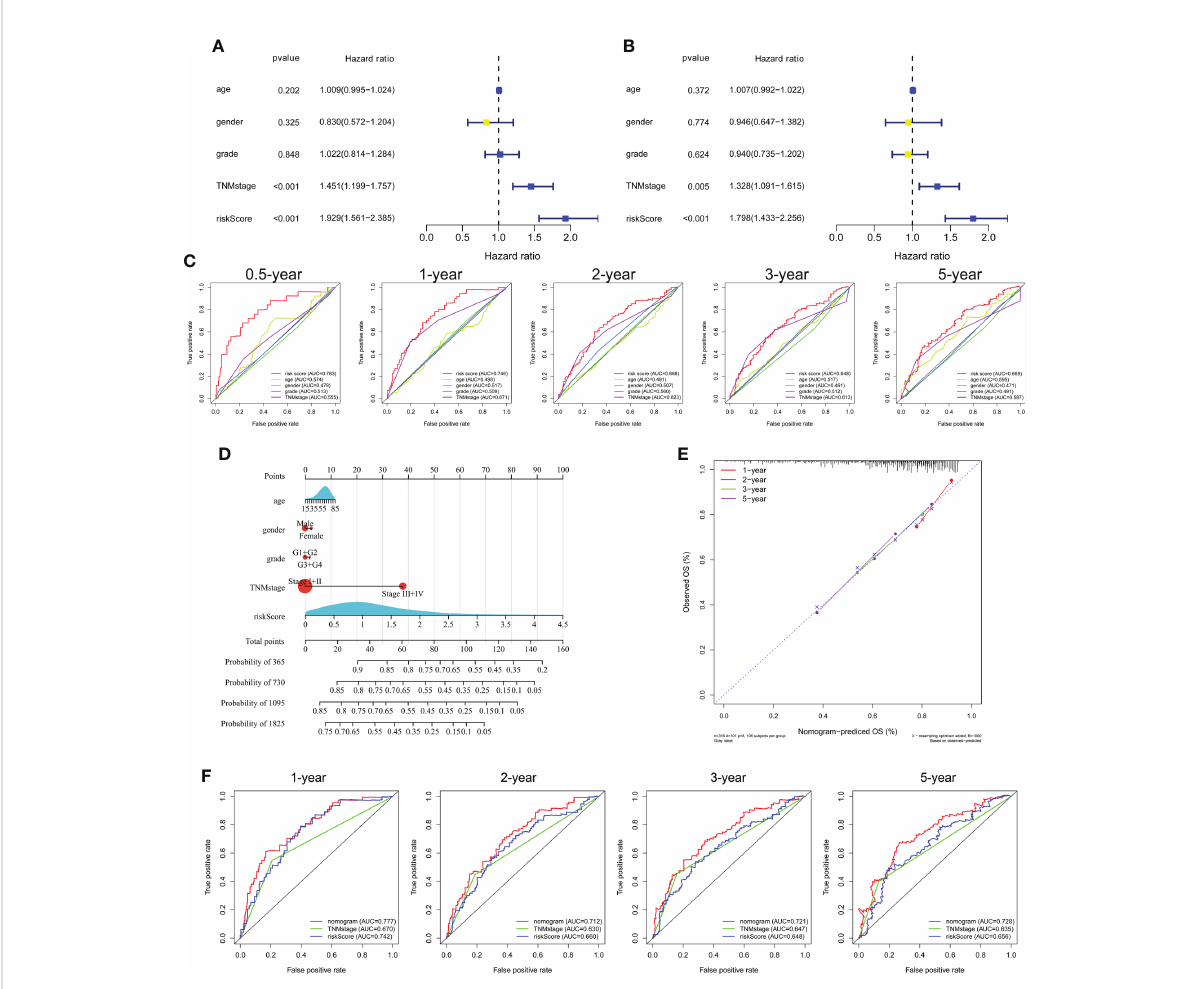
FIGURE 5 Independent prognostic power of the three genes comprising the signature in the TCGA cohort. (A) Univariate and (B) multivariate Cox regression analyses of the associations of the risk index (RI) and clinical parameters with OS. (C) ROC curve of the prognostic utility of the risk score, age, gender, grade, and TNM stage. (D) Nomogram for predicting 1-, 2-, 3-, and 5-year survival. (E) Calibration curves of the nomogram showed consistency in the predicted and observed 1-, 2-, 3-, and 5-year survival rates. (F) ROC curve analysis of the nomogram for 1-, 2-, 3-, and 5-year